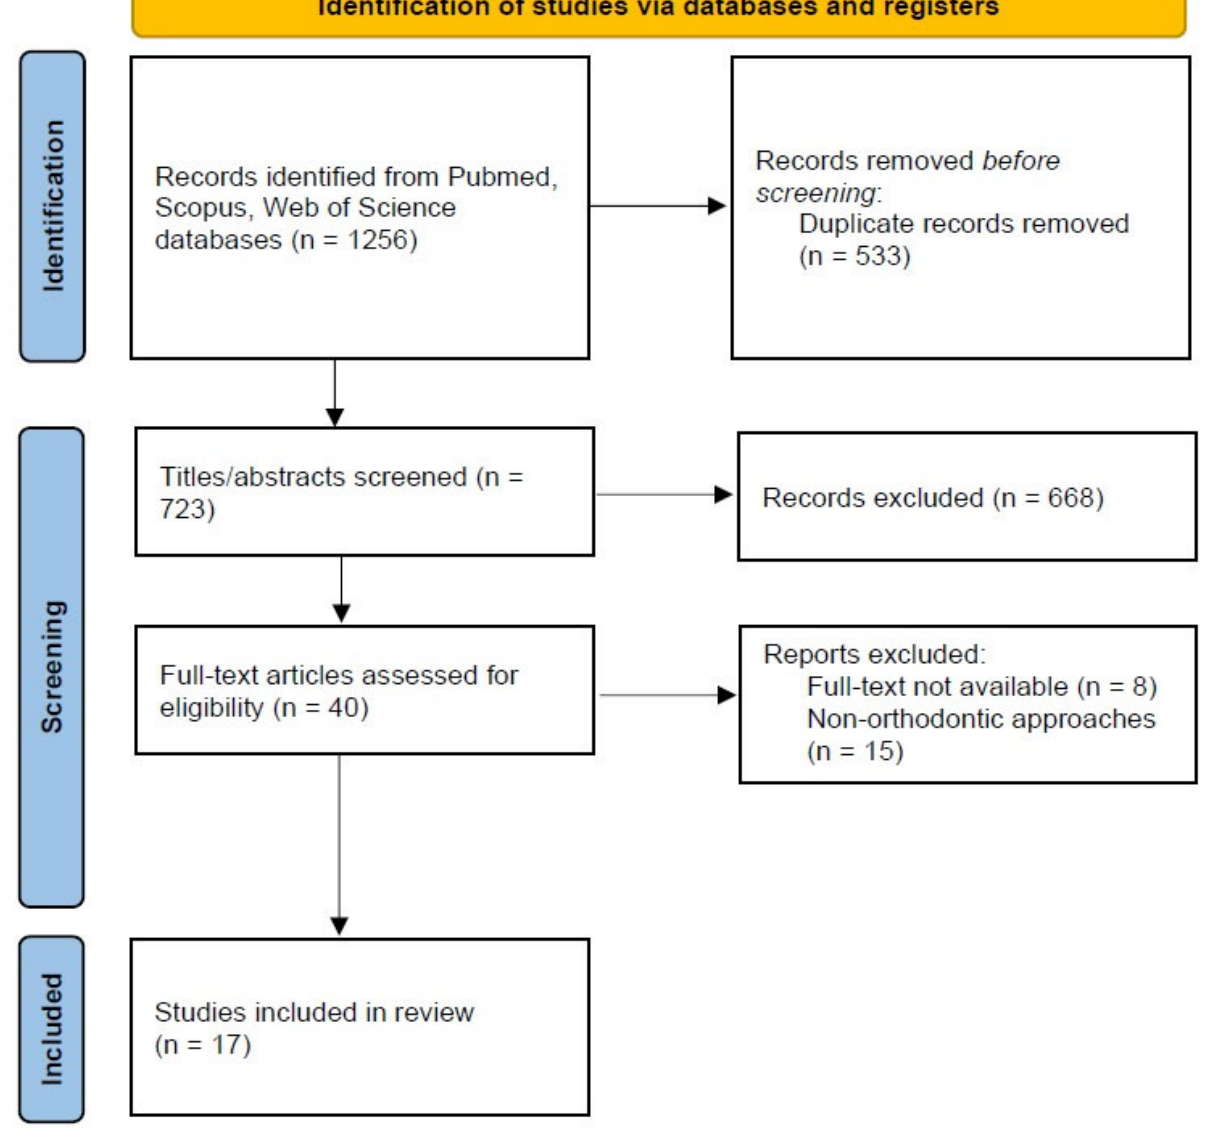
Figure 1. PRISMA-ScR flow diagram of the articles’ Figure 1. PRISMA ‐ ScR fl ow diagram of the articles’ identi fi cation.